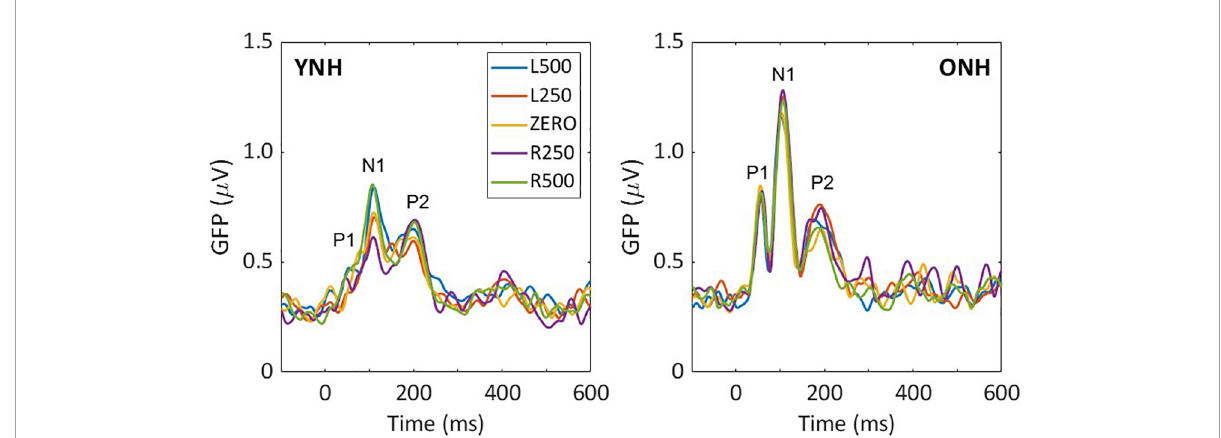
FIGURE3 Grand average sensor-based global-field power (GFP) responses for each interaural time difference (ITD) condition and each listener group; young (left) and older (right) . The three main peak components are labeled in each panel (P1, N1, P2).